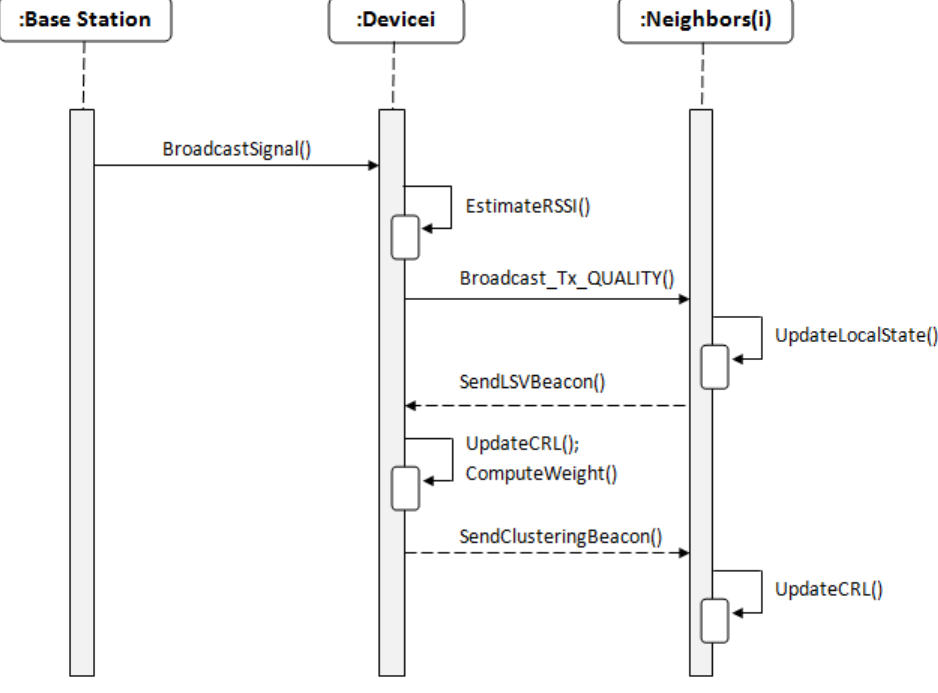
Figure 4. Sequence diagram of the initialization